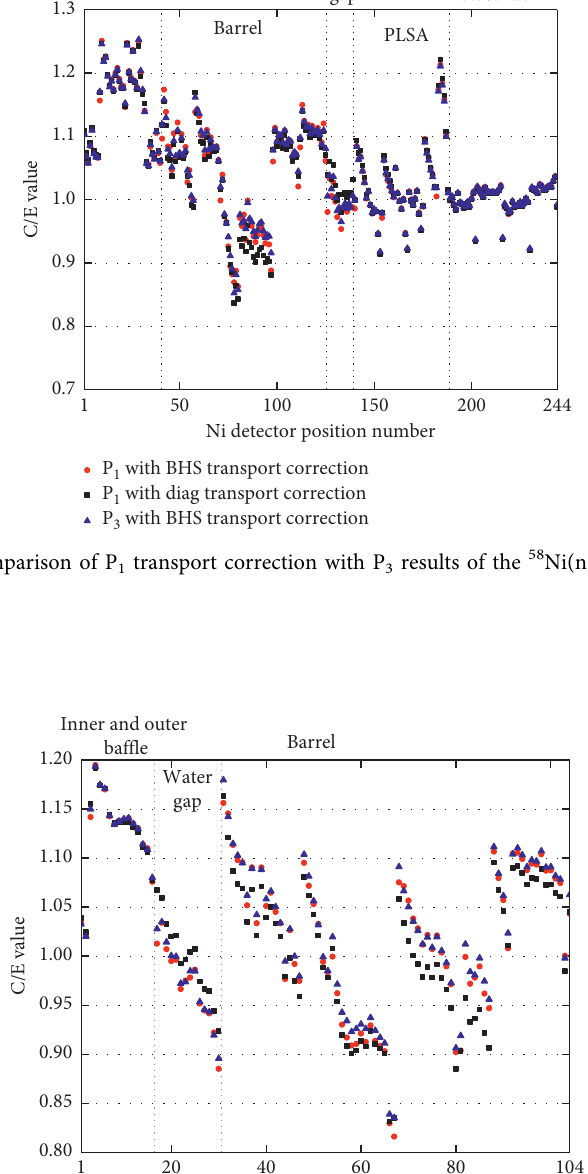
115 In(n,n’) 115m In